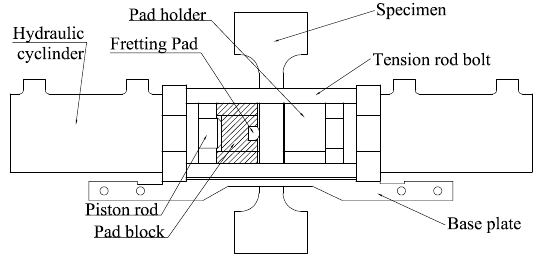
Table 3. Experimental parameters used in fretting fatigue tests. Figure 7. Schematic diagram of the fretting fatigue rig. Figure 7. Schematic diagram of the fretting fatigue rig.